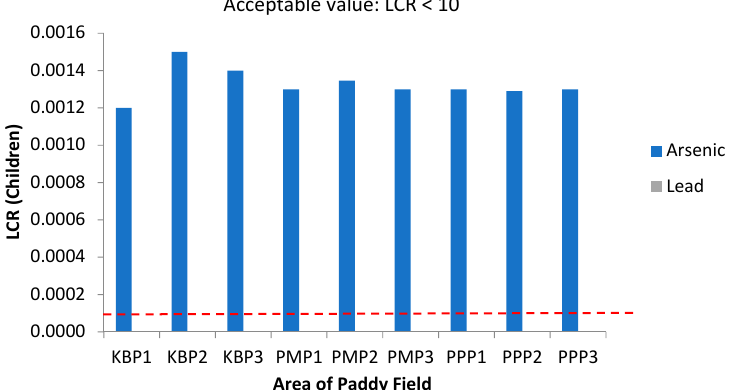
Figure 11. Lifetime cancer risk (LCR) values for children via intake of rice from the different sampling sites in Kelantan. KBP1: Kota Bharu Plot 1, KBP2: Kota Bharu Plot 2, KBP3: Kota Bharu Plot 3, PMP1: Pasir Mas Plot 1, PMP2: Pasir Mas Plot 2, PMP3: Pasir Mas Plot 3, PPP1: Pasir Puteh Plot 1, PPP2: Pasir Puteh Plot 2, and PPP3: Pasir Puteh Plot 3.